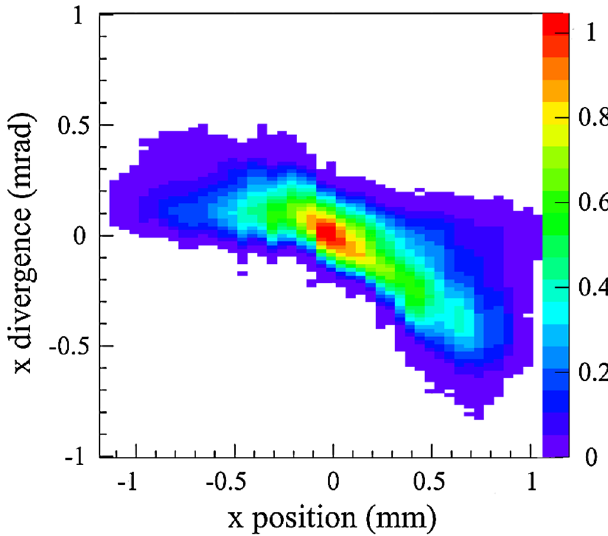
FIG. 31. (Color) Horizontal phase-space distribution at 4.3 m from the cathode, gun prototype 3.1 at (cid:2) 43 MV = m , total beam momentum 12 : 99 MeV =c , main solenoid current of 282 A, rf phases with respect to maximum mean momentum gain of gun, (cid:5) 2 deg , and booster, (cid:5) 5 deg .